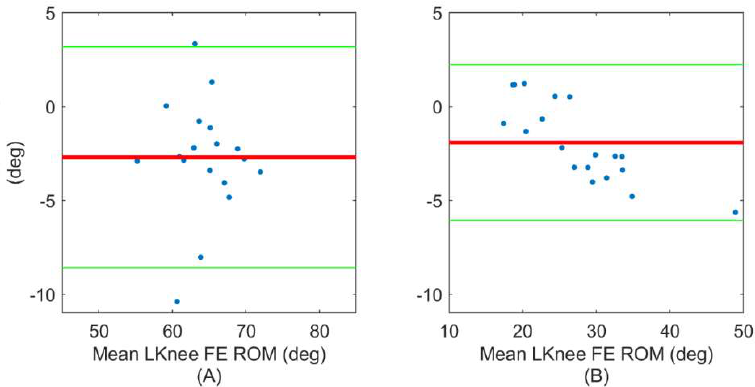
Figure 5. Bland–Altman plots of the left knee mean flexion/extension (FE) range of motion during ( A ) normal walking and ( B ) lateral left walking. Comparison is between IMU and IK methods (IMU-IK). Plot represents matched estimates for all 19 subjects evaluated in these movements. Bias (thick, red) and 95% limits of agreement (thin, green) are also displayed. Limits of agreement calculated as Bias ± 1.96 SD where Bias is the mean and SD is the standard deviation of the differences in the estimates.